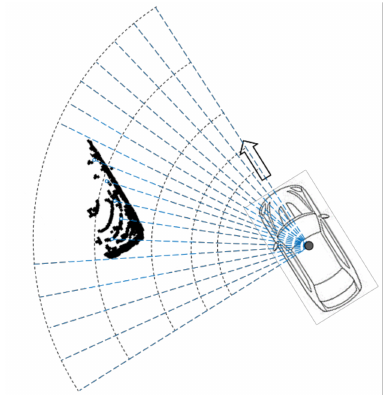
Figure 9. Illustration of diagonal obstacle point cloud formation. When the LiDAR transmitter emits a laser pulse, the emitted laser beam irradiates the surface of the obstacle object and forms the return light. Therefore, the point cloud has a diagonal shape when the obstacle vehicle’s relative position is